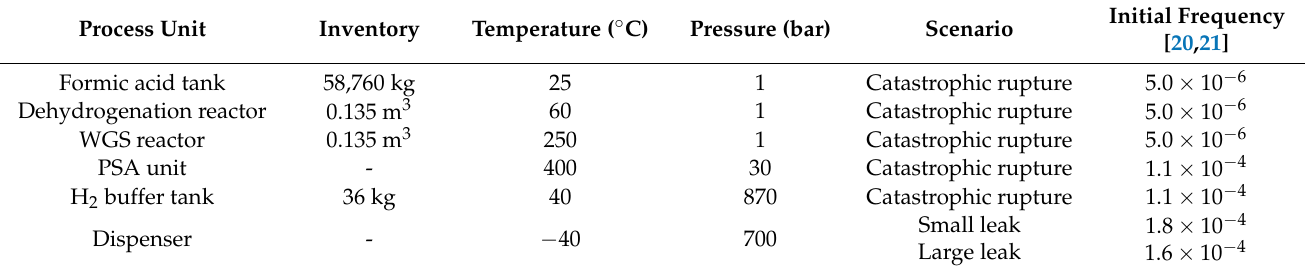
Figure 2. Schematic PFD of the GHRS system. Table 1. Accident scenarios of the FAHRS system. Scenarios are defined for the individual units, and the operating conditions of the units and the corresponding initial frequency values obtained from literature are provided.